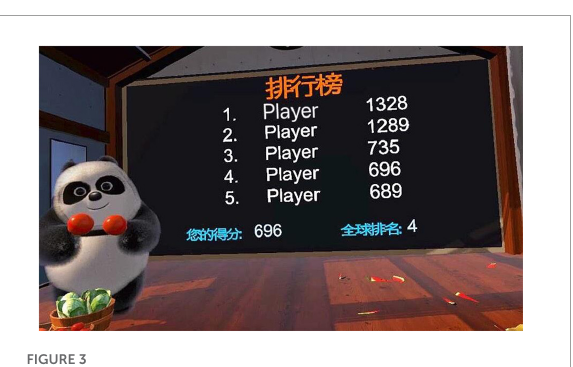
FIGURE2 The long knife was controlled by a hand device.